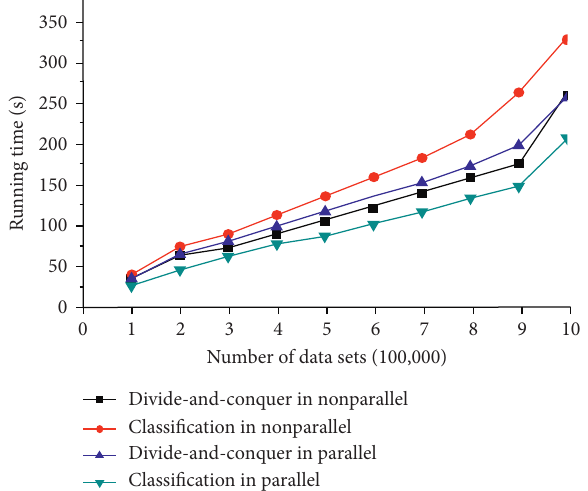
Figure 3: Comparison of the two algorithms in nonparallel and parallel